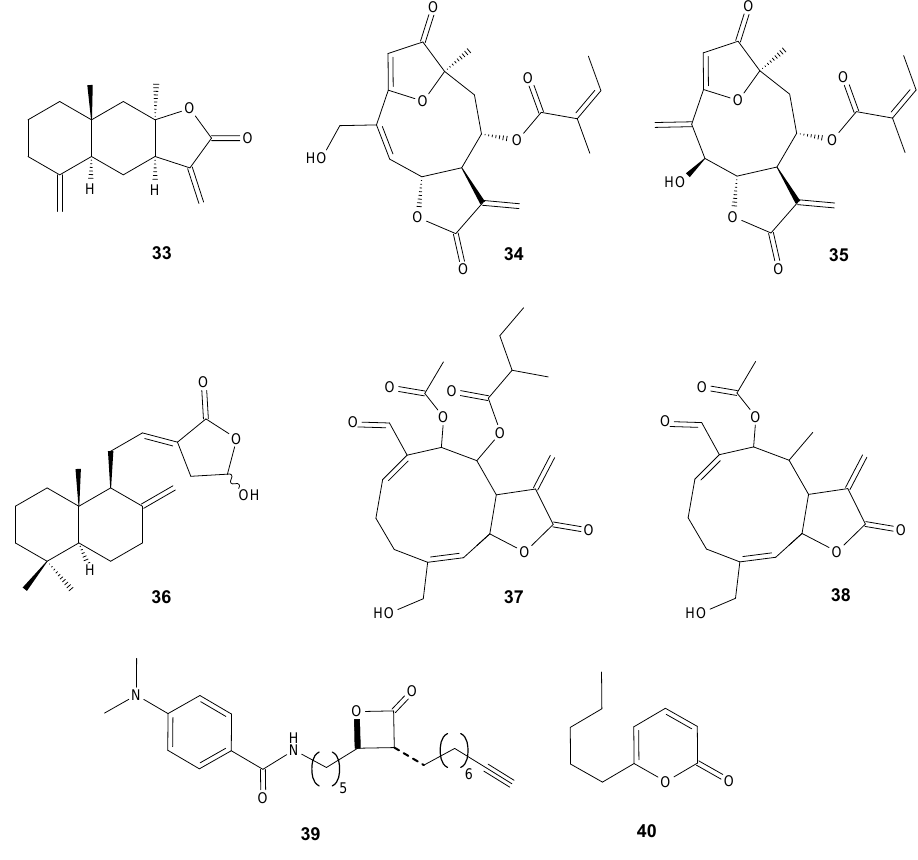
Figure 2. Lactones 33 – 40 .